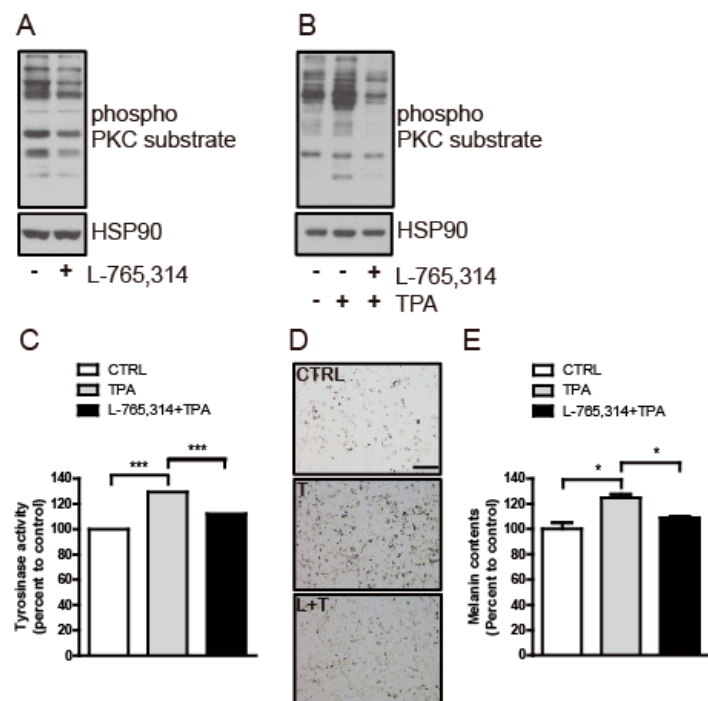
Figure 6. Protein Kinase C (PKC)-stimulated tyrosinase activity was attenuated by L-765,314. ( A ) PKC activity was assessed in Mel-ab cells treated with L-765,314 for 96 h by immunoblotting with phospho-PKC substrate antibody. ( B ) The PKC activity and ( C ) tyrosinase activity of Mel-ab cells treated with vehicle, 12- O -Tetradecanoylphorbol 13-acetate (TPA), or L-765,314 and TPA were examined. ( D ) Microscopic images and ( E ) melanin contents of Mel-ab cells treated with vehicle, TPA, or TPA with L-765,314. *, ** and *** represents p < 0.05, p < 0.01, and p < 0.001 respectively.